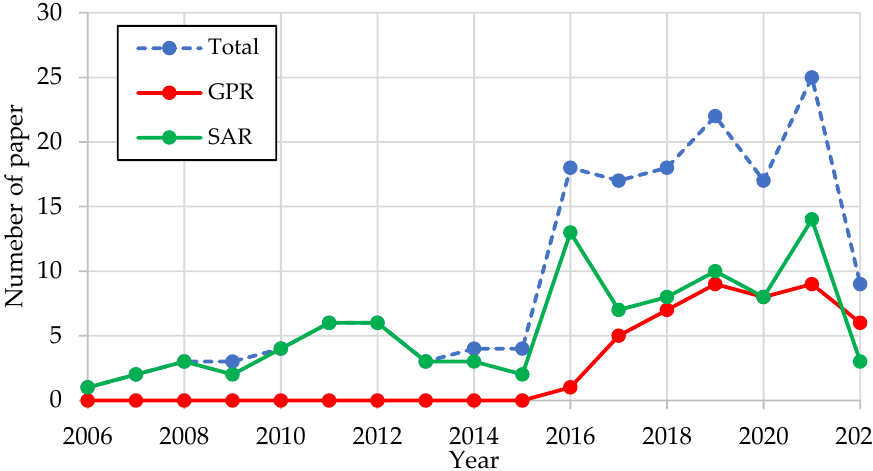
Figure 15. Number of papers per year: The blue dashed line shows the total number of papers, the green line shows the papers with SAR application, and the red line shows the papers with GPR application.